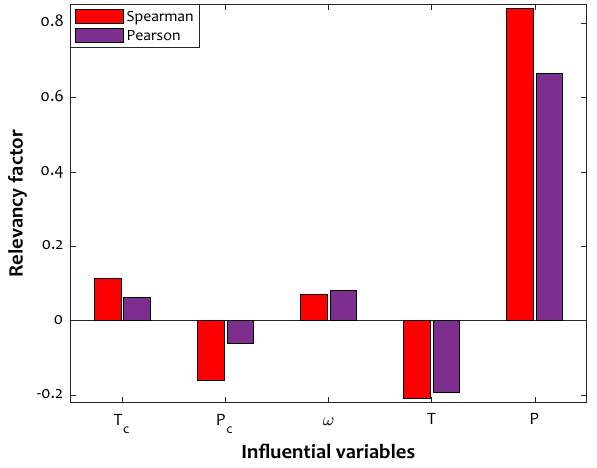
Figure 8. Dependence of H 2 S solubility in ILs on its influential parameters.